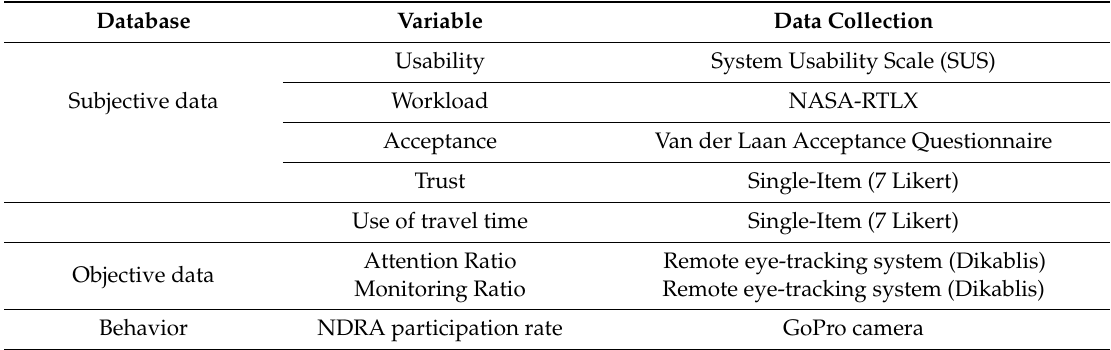
Table 1. Summary of variables used in the presented